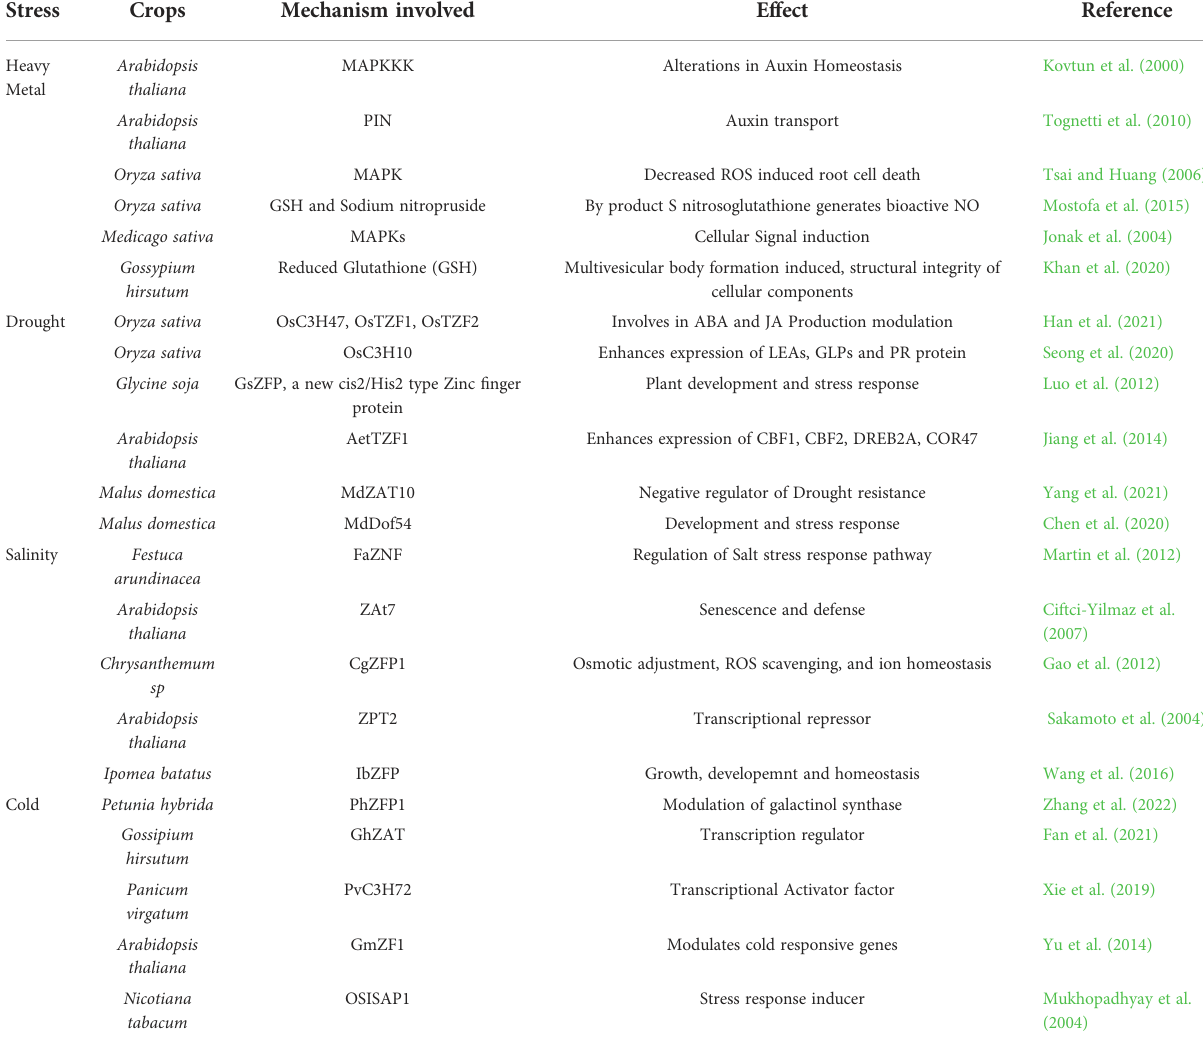
TABLE 1 The effect of different Zinc fi nger protein in mitigating various abiotic